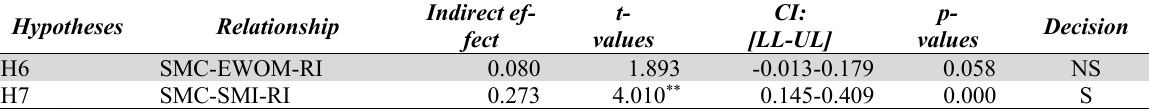
Structural model result for the indirect